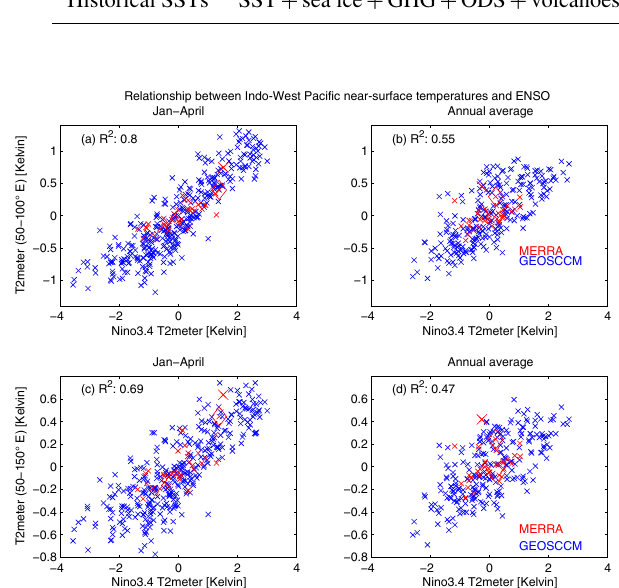
Figure 1. Relationship between near surface temperatures over the Niño-3.4 region and over the Indian Ocean and western Pacific basins from 5 ◦ S to 5 ◦ N in (blue) the GEOSCCM coupled ocean– atmosphere integration and in (red) MERRA reanalysis data. The EN event 1982/1983 is indicated with a large red diamond, and the EN event in 1997/1998 is indicated with a large x. (a, c) January through April; (b, d) annual average. (a, b) Indian Ocean from 50 to 100 ◦ E; (c, d) Indo-West Pacific from 50 to 150 ◦